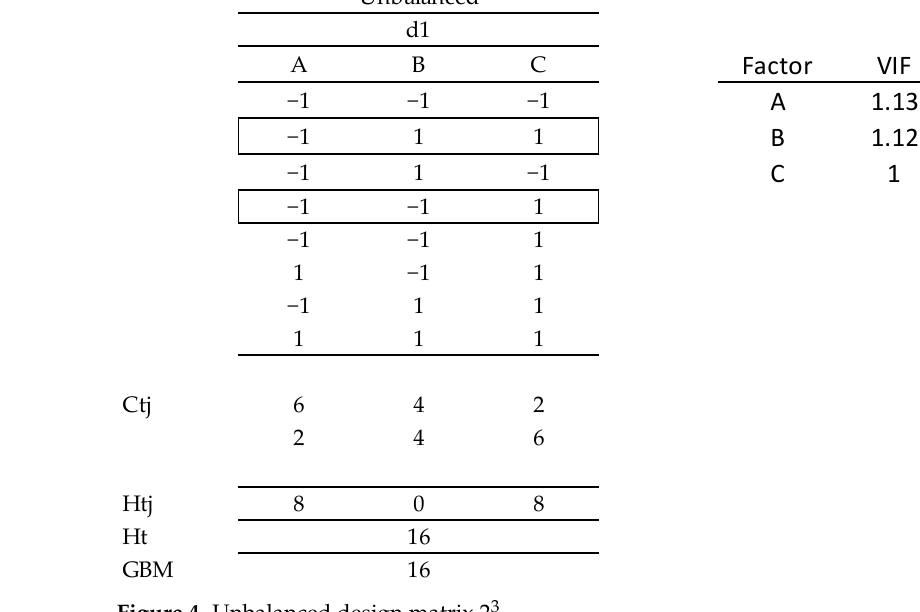
Figure 4. Unbalanced design matrix 2 3.